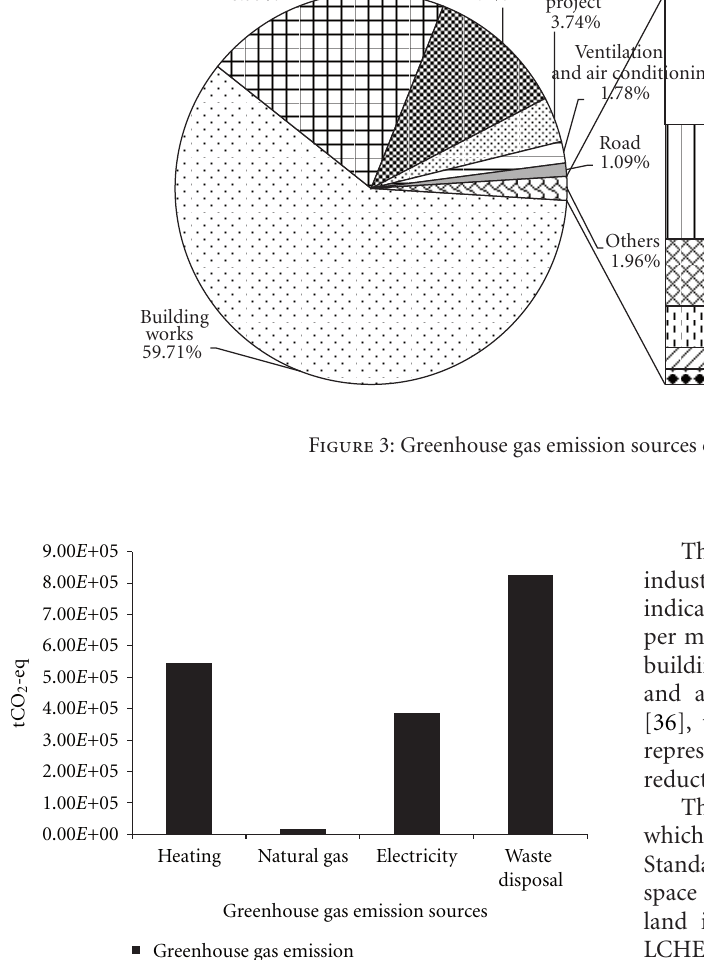
Figure 4: Greenhouse gas emission sources of the operation